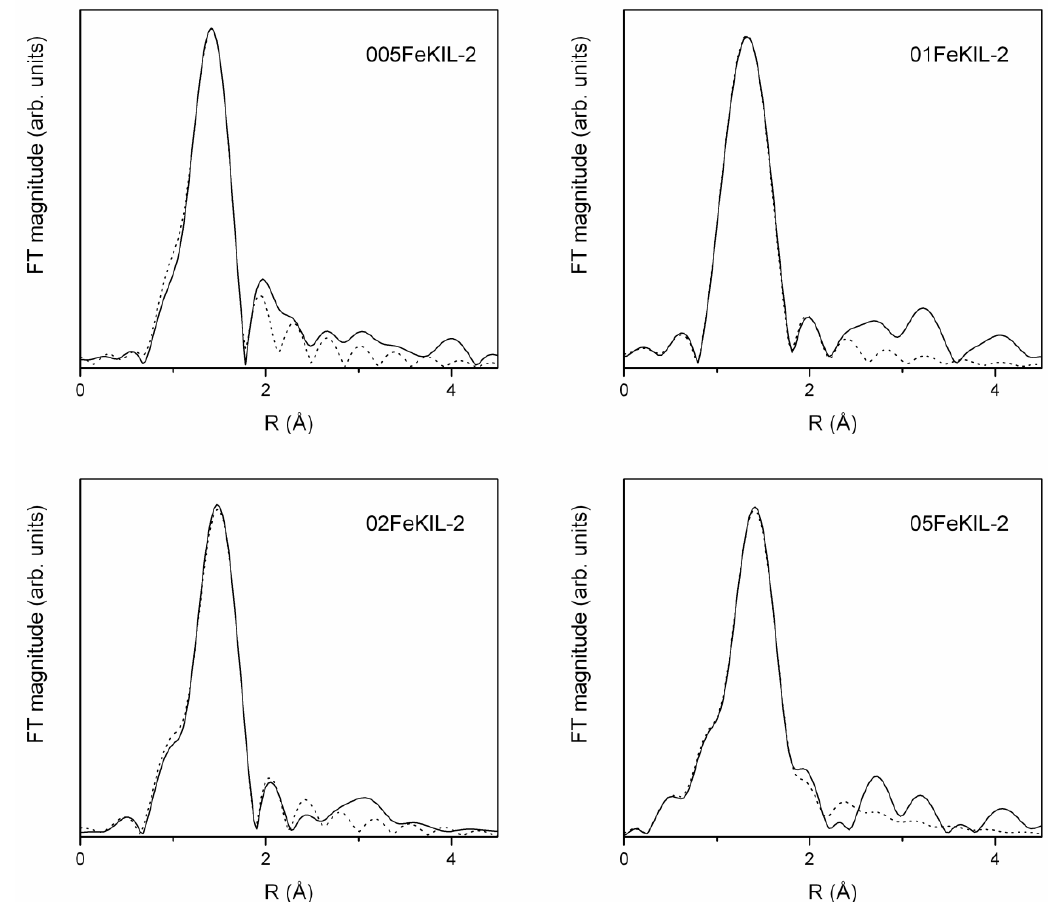
Figure 6. Fourier transform magnitudes of the k 3 -weighed Fe extended X-Ray absorption fine structure (EXAFS) data of FeKIL-2 samples (solid line—experiment; dotted line—EXAFS model).